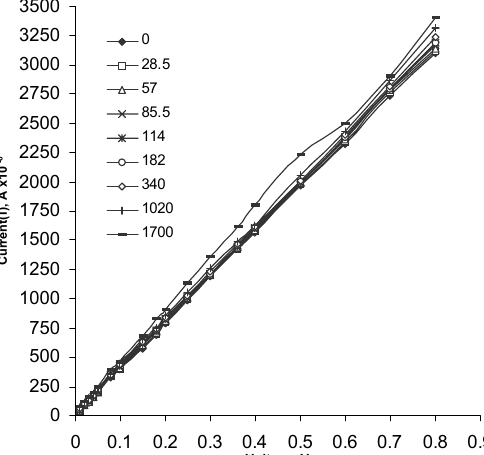
Figure 10. I-V plots of as-printed and γ -irradiated at different doses NiO interdigitated planar structures doped with 0.2 wt.% of